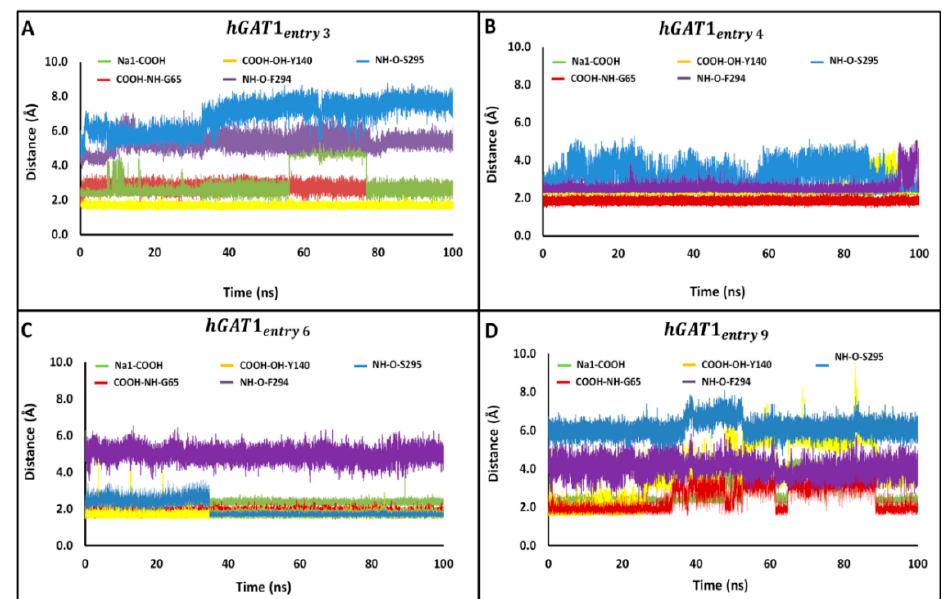
Figure 5. Distances between the tiagabine enantiomers and hGAT1 interaction site residues. Time series are shown for distances between the protonated –NH group of tiagabine and F294(O)/S295(O); and between the average position of –COOH group of tiagabine and G65 (–NH), Y140 (–OH), and Na1 of the entries 3, 4, 6, and 9 representing the complexes ( A ) hGAT1 entry 3 , ( B ) hGAT1 entry 4 , ( C ) hGAT1 entry 6 , and ( D ) hGAT1 entry 9 , respectively, of Table 1.